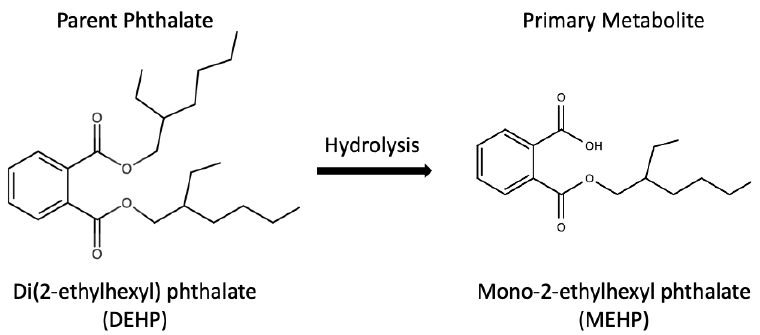
Figure 2. Metabolic pathway from DEHP to MEHP